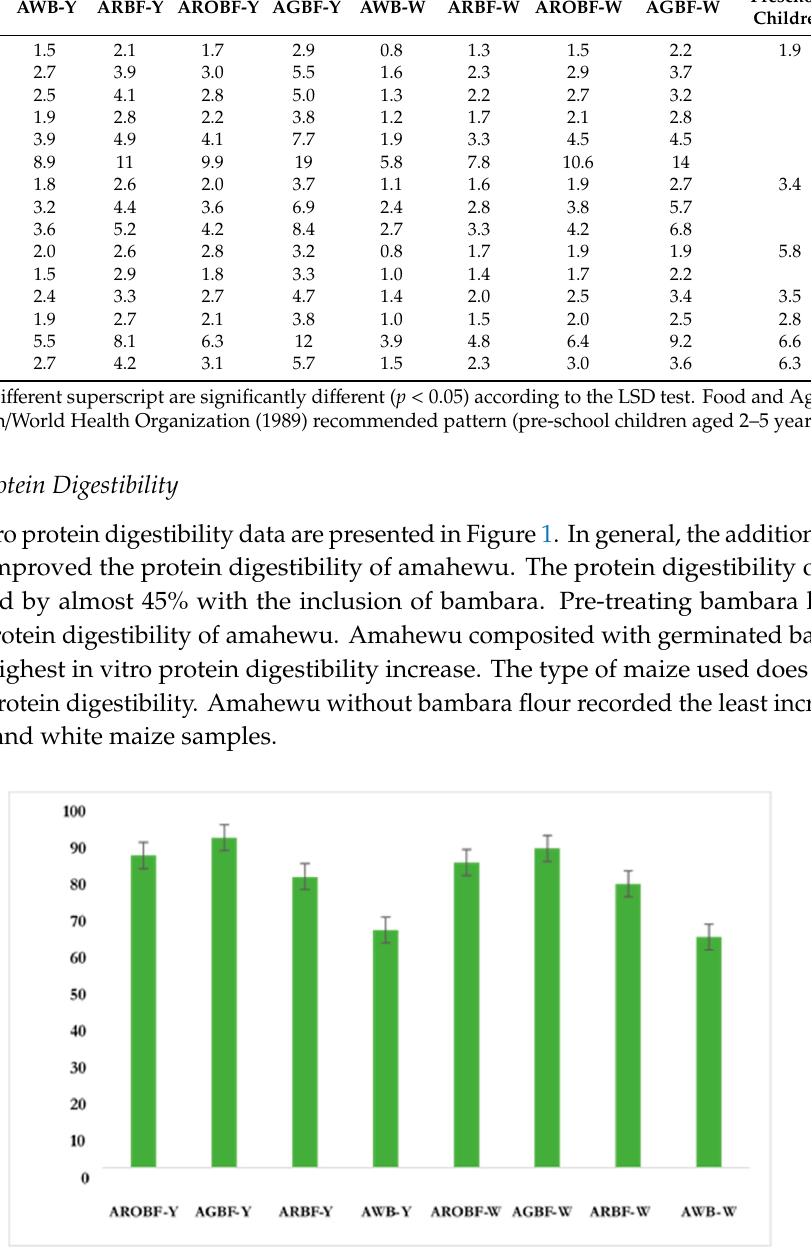
Figure 1. Protein digestibility of amahewu samples.